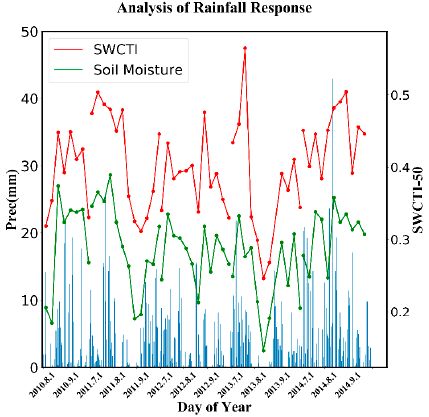
Figure 13. Response of SWCTI to rainfall events.